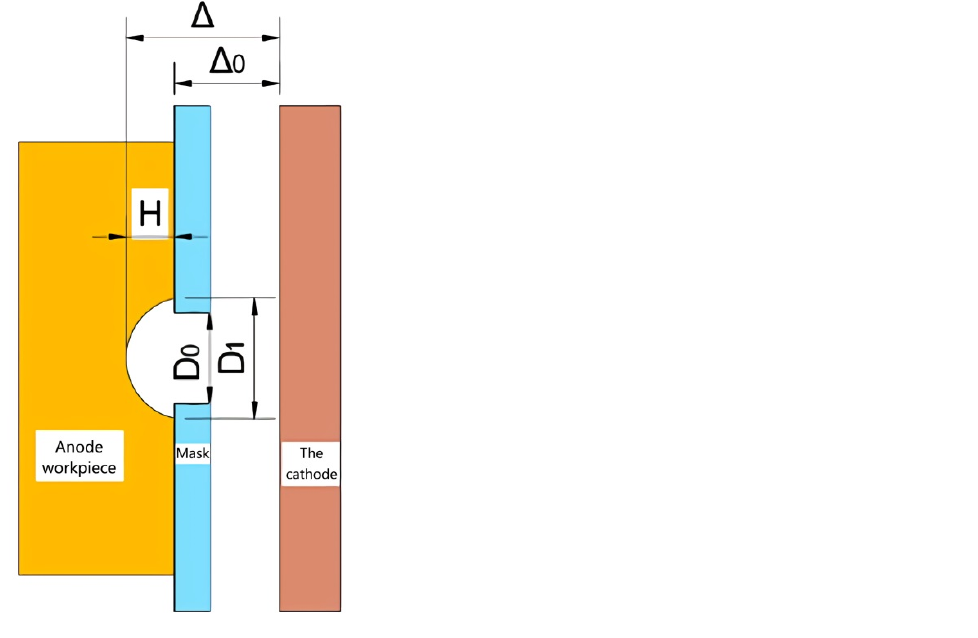
( b ) Figure 4. Machining area model of ring groove. ( a ) Three-dimensional model of ring groove ma- chining; ( b ) Two-dimensional mathematical model. 3.2. Multi-Physical Field Coupling Analysis The electrochemical machining process of a ring cell and its complexity involve flow field, electric field, temperature field, and structural field, which vary and affect each other at any time [29]. The flow field and electric field affect the conductivity and current efficiency, and the conductivity increases with the increase in temperature, which leads to the change in workpiece erosion rate and then affects the distribution of the electric field and flow field [30,31]. The electric field model (Equation (2)) and the flow field model (Equation (3)) are substituted into the current density Equation (4) to obtain the coupling Equation (5) of the flow field and the electric field [32–34]: